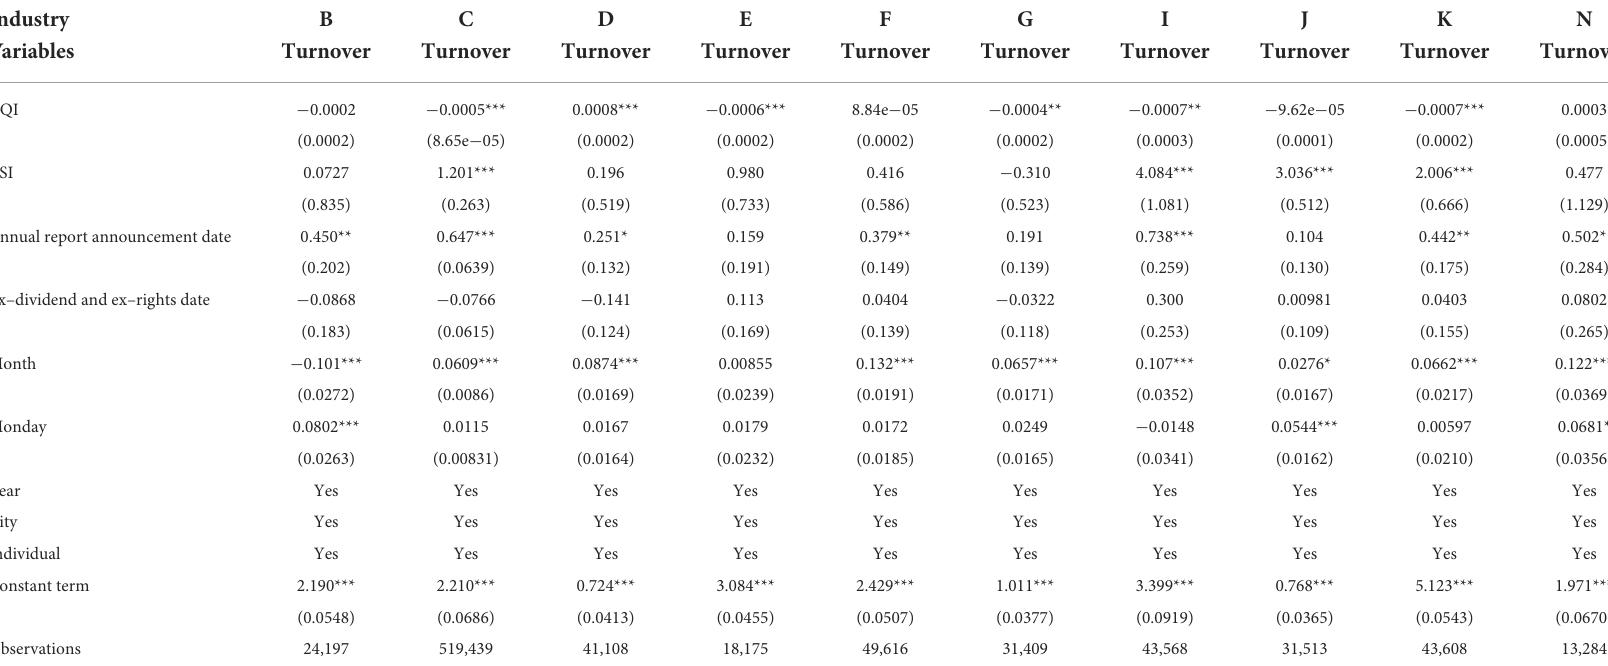
TABLE 4 Test for different